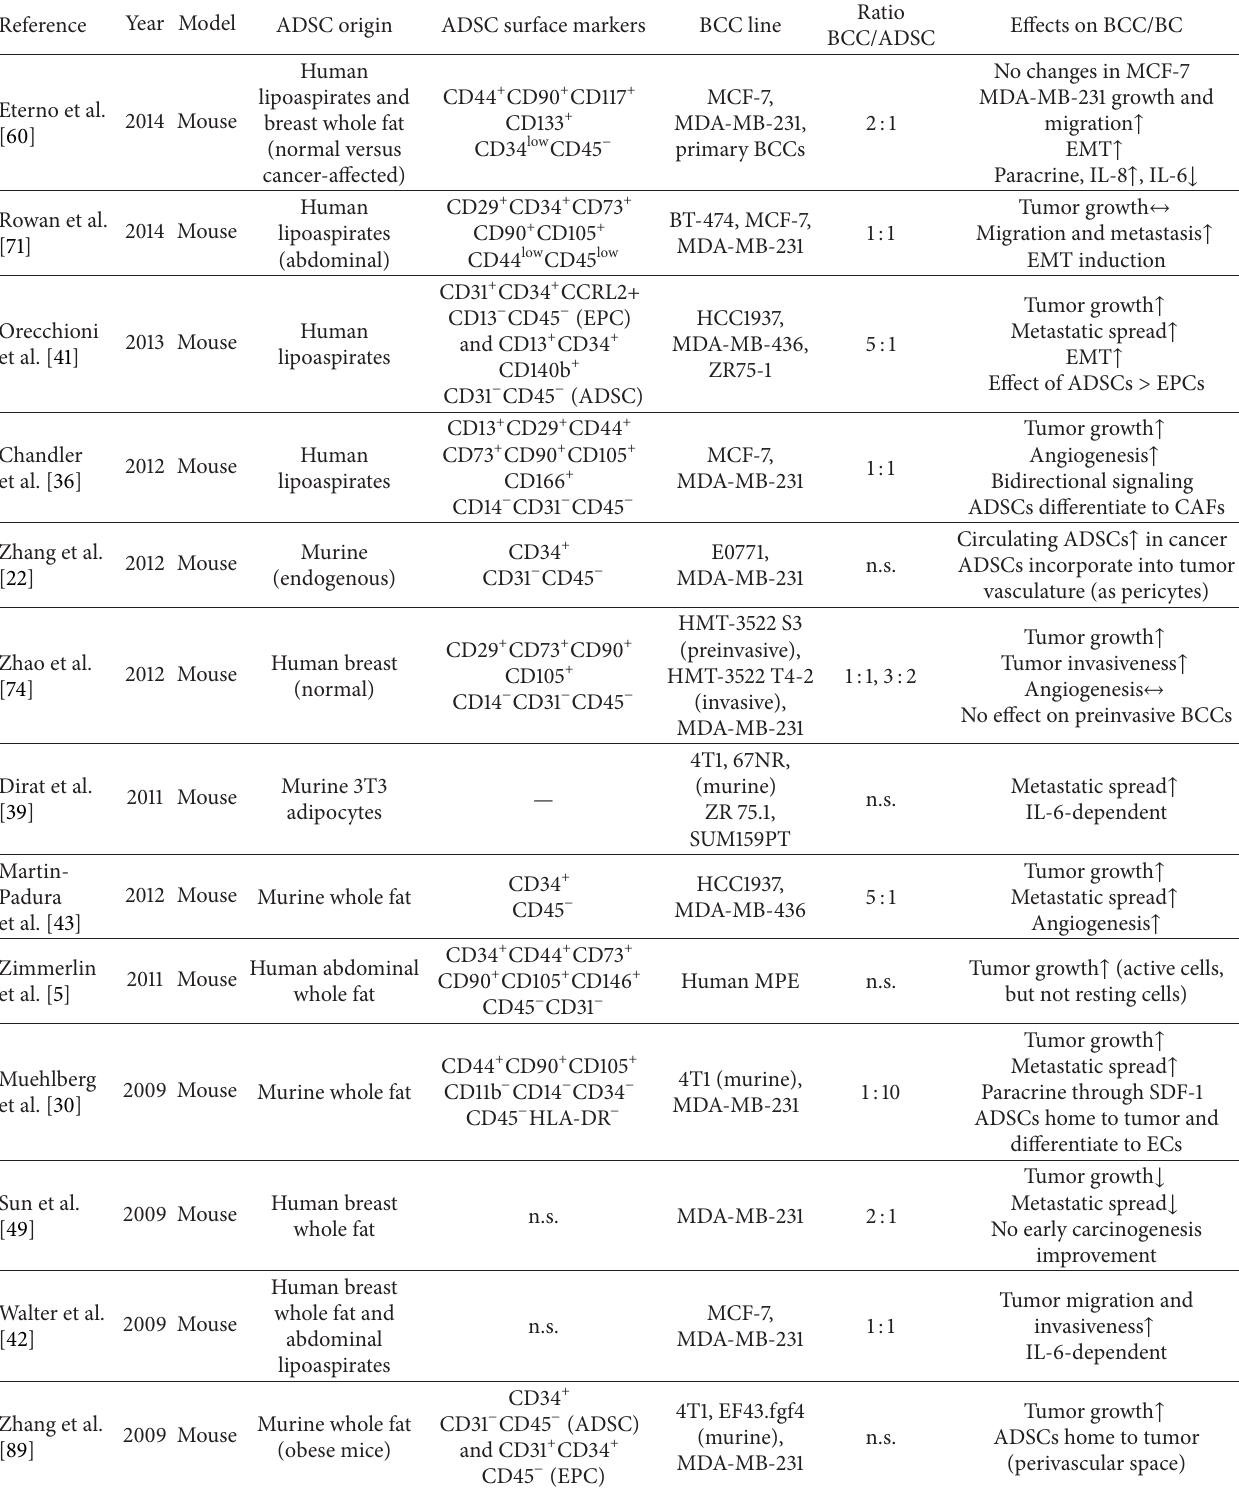
Table 3: Relevant in vivo studies investigating the effects of ADSCs on breast